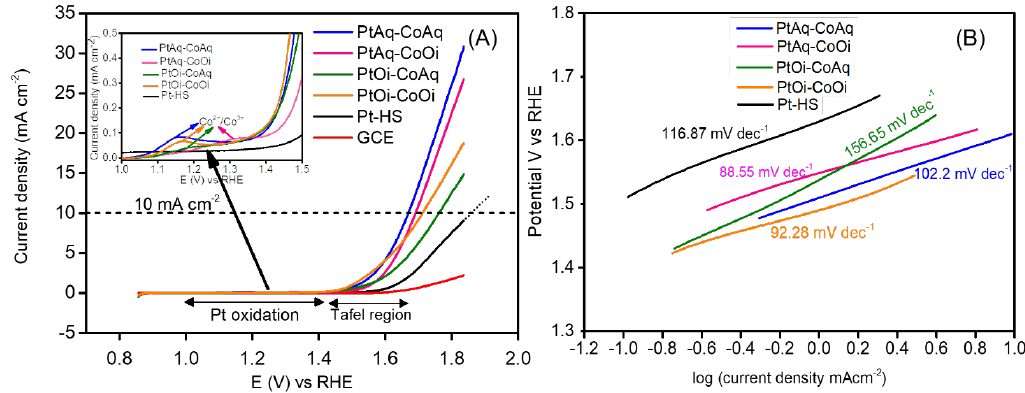
Figure 6. ( A ): LSV curves for OER activity of PtAq-CoAq, PtAq-CoOi, PtOi-CoAq, PtOi-CoOi and Pt-HS in 0.1 M KOH at a scan rate of 1 mV / s. ( B ) Tafel plots for PtAq-CoAq, PtAq-CoOi, PtOi-CoAq, PtOi-CoOi and Pt-HS.